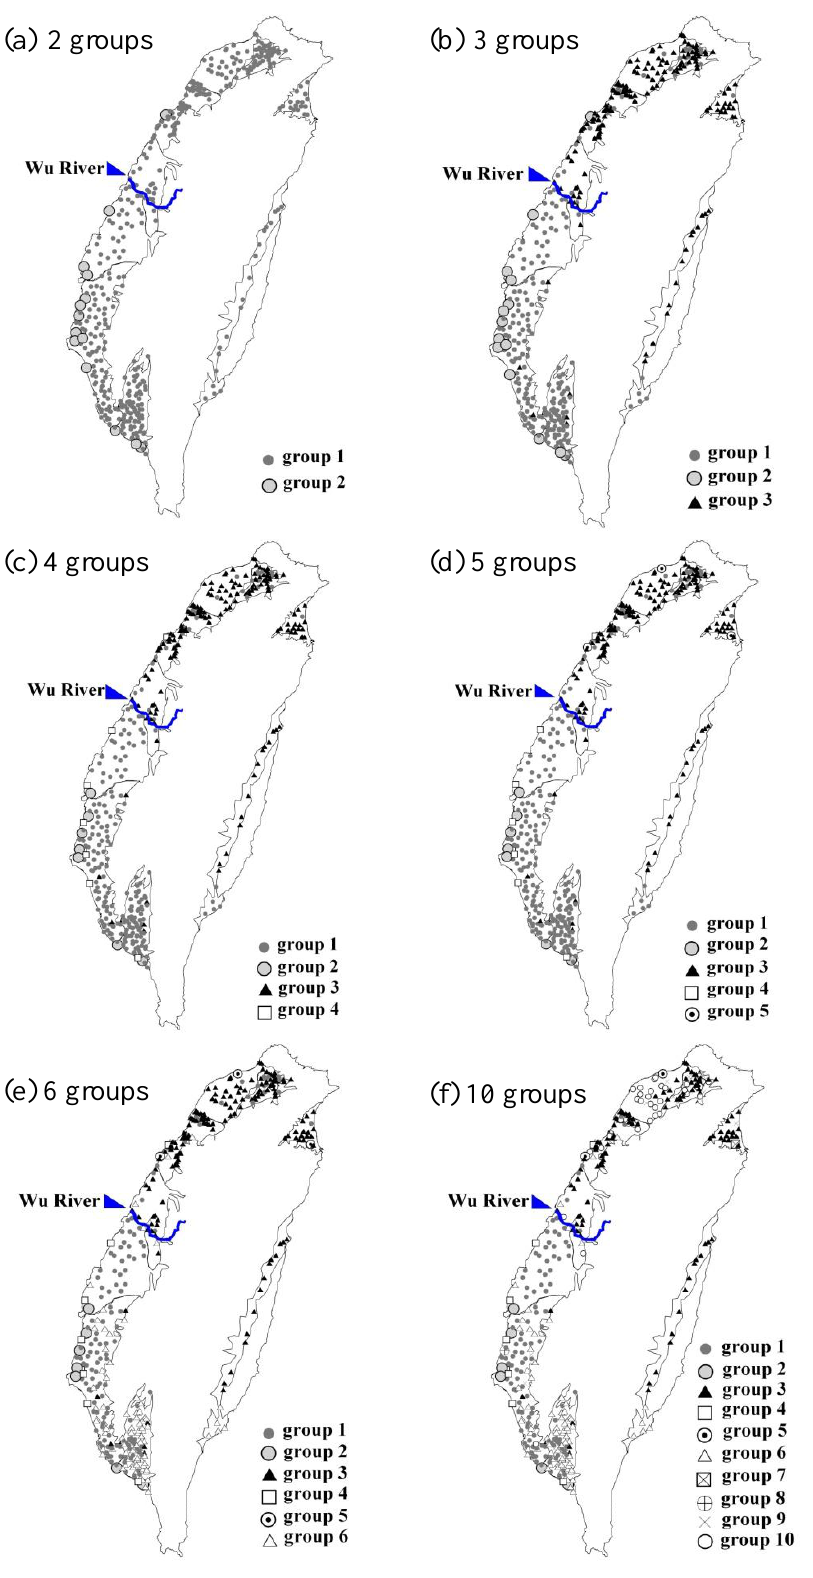
Figure 2. Overlay map of the spatial distribution of cluster analysis